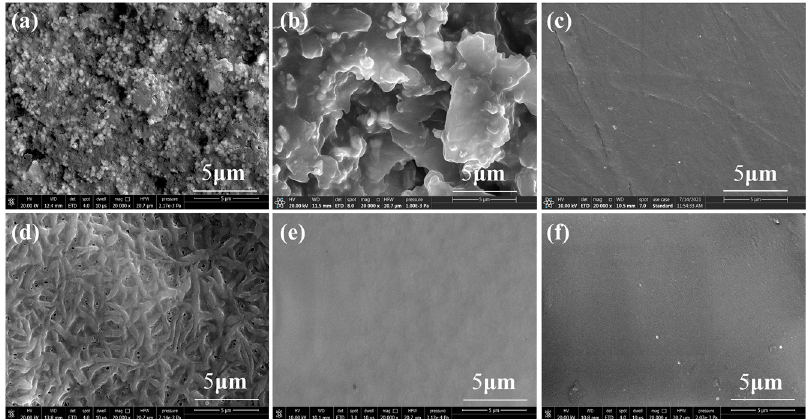
Figure 5. Surface micrographs of the coating surfaces: ( a ) nano-ceramic coating, ( b ) bilayer water- borne PTFE coating, ( c ) Whitford Xylan 8840 coating, ( d ) polytetrafluoroethylene (PTFE) coating, ( e ) perfluoroalkoxy (PFA) coating, ( f ) fluorinated ethylene propylene (FEP) coating.